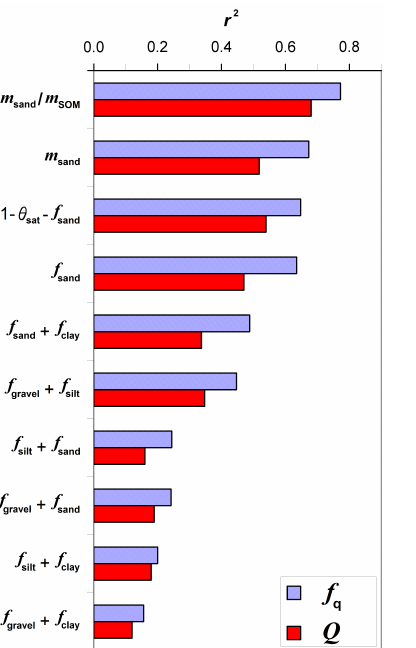
Figure 4. Fraction of variance ( r 2 ) of gravimetric and volumetric fraction of quartz ( Q and f q , red and blue bars, respectively) ex- plained by various predictors.